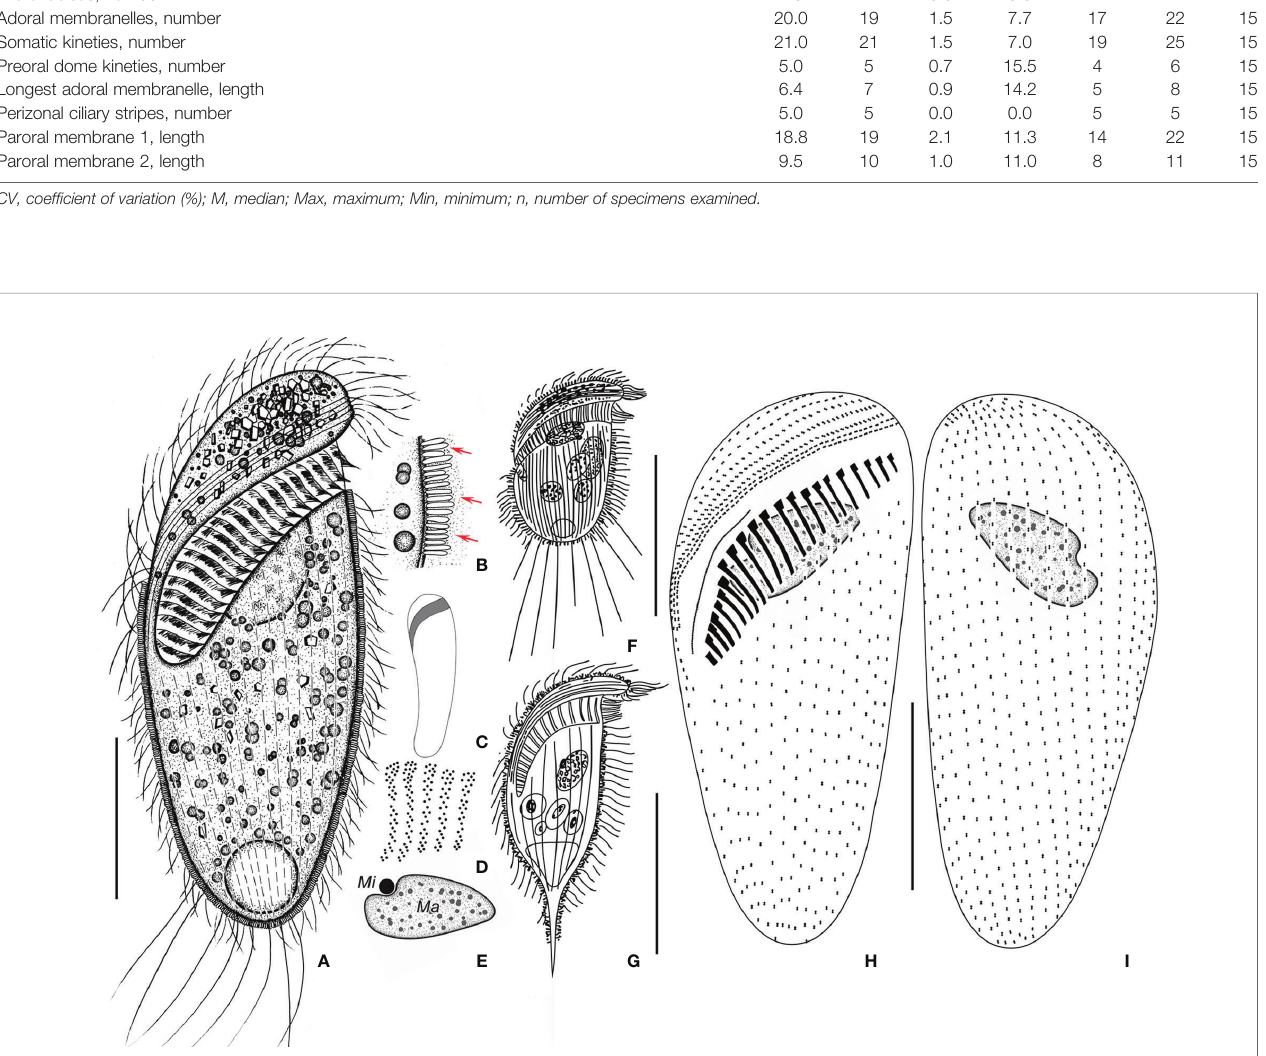
FIGURE 6 | Metopus parapellitus sp. n. from life (A – C, E) and after protargol staining (D, H, I) , and M. vestitus ( E ) and M. contortus pellitus (F) after Kahl, 1932. (A) Ventral view of a representative specimen, showing body shape, ectosymbionts, contractile vacuole, and long caudal cilia. (B) Ectosymbionts (arrows). (C) Left view showing body shape. (D) Structure of membranelles from the mid-portion of the adoral zone. (E) Micronucleus and macronucleus. (F) Metopus vestitus after Kahl (1932). (G) M. contortus pellitus after Kahl, 1932. (H, I) Ventral (H) and dorsal (I) view of the holotype, showing ciliature and macronucleus. Ma, macronucleus; Mi, micronucleus. Scale bars: 30 m m (A, G) , 50 m m (G) , and 25 m m (H, I)